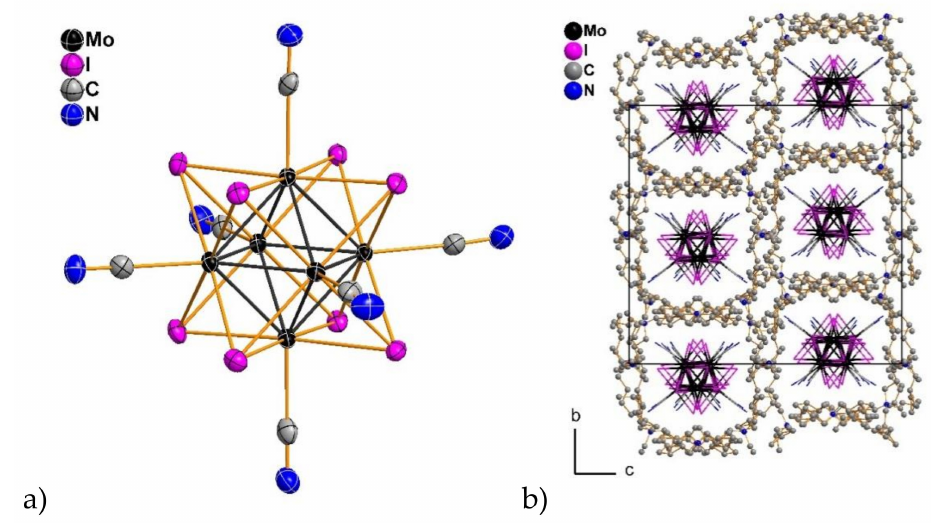
Figure 4. Structure of the [{Mo 6 I 8 }(CN) 6 ] 2 − cluster anion in the structure of compound 2 . Atoms are shown as thermal ellipsoids of 50% probability ( a ); packing of the cluster anions and Bu 4 N + cations in the structure of compound 2 , view in bc plane ( b ). Table 1. Selected interatomic distances within [Mo 6 I 8 (CN) 6 ] 2 − , trans -[Mo 6 I 8 (CN) 4 (MeO) 2 ] 2 −